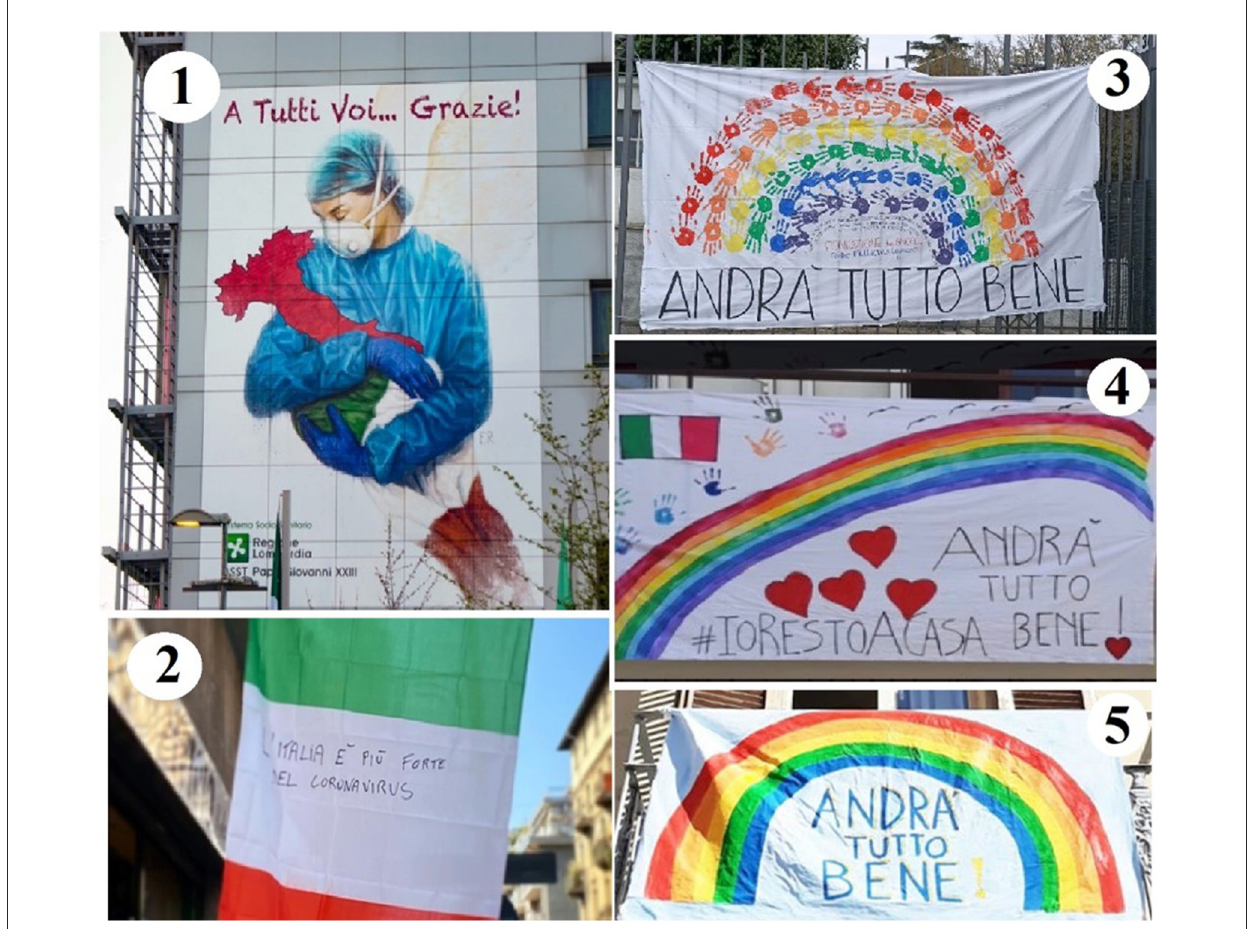
FIGURE2 Photo 1—murals from the Lombardy region to support doctors and nurses; Photo 2—patriotism in the LL; Photo 3, Photo 4, and Photo 5—“Everything will be all right” banners.